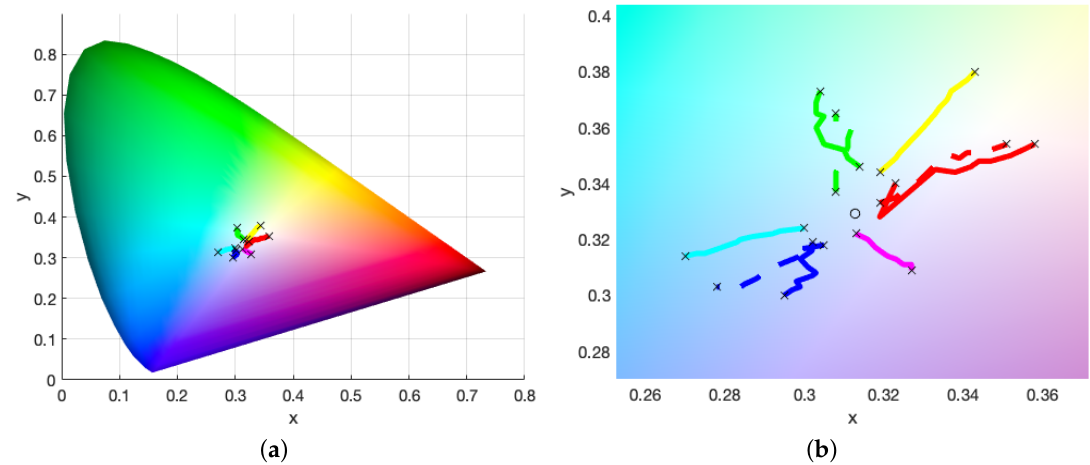
Figure 7. ( a ) CIE xyY values for a set of extremely weak Woodburytype inks, showing the three single layer prints possible with CMY inks. The inks chosen are weak as the multi-layering process here effectively doubles the print height range with each layer that is added. The region of “infinitely thick” films whereby all colour is produced by reflectance at the surface, is easily reached by the Woodburytype process due to the increasing print height. The intended print colour is indicated by the line colour, for instance, cyan for the cyan ink and so on, and the minimum and maximum steps are highlighted with black crosses to stand out from the background further. The double-layer prints, resulting in red, green and blue, are also shown. ( b ) The same data, but zoomed in further for clarity. The white point, x = 0.31271, y = 0.32902, is highlighted with a circular point, alongside the equivalent double-layer prints that are switched in print order (i.e., CM → MC ), represented by the dashed lines of the same